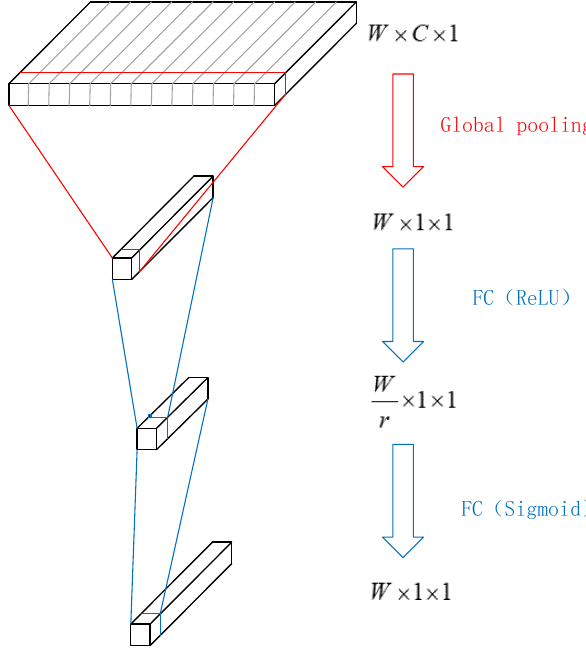
Figure 4. SE block in TCN.